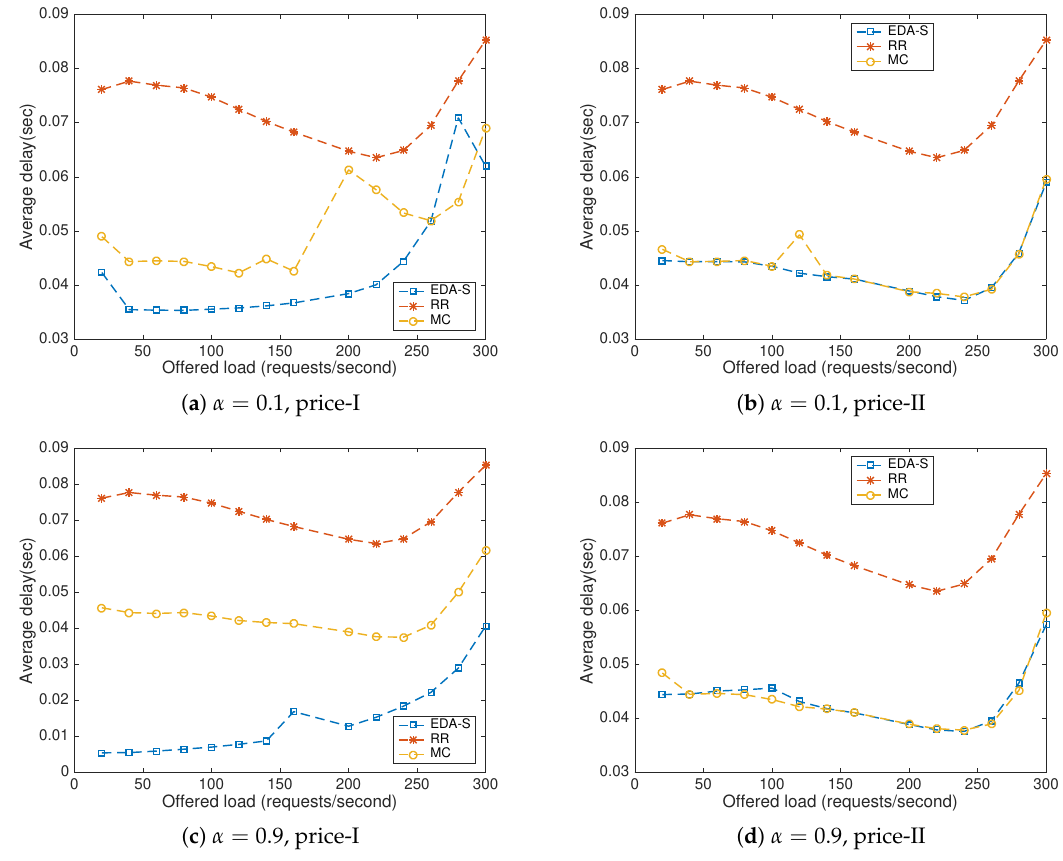
Figure 9. Average delay with CA-S tested in